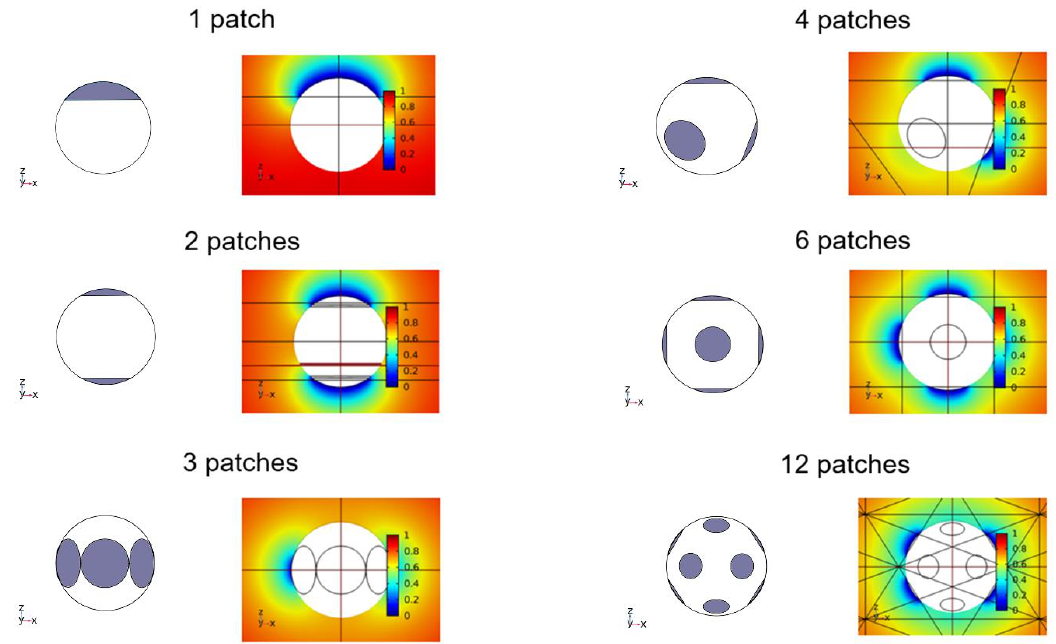
Figure 2. Concentration color maps for symmetric arrangements of 𝑁 identical reactive patches with 𝜎 = 0.2, which are at two opposite poles ( 𝑁 = 2), equilateral triangular ( 𝑁 = 3), tetrahedral ( 𝑁 = 4), octahedral ( 𝑁 = 6), and icosahedral ( 𝑁 = 12), together with the case of a single patch ( 𝑁 = 1). For each case, to clearly show the patch arrangement, we display the patch arrangements without colors in the figures to the left of the color maps. Note that the lines shown here have nothing to do with reactions and are auxiliary lines used in COMSOL. The figures were prepared by using COMSOL.